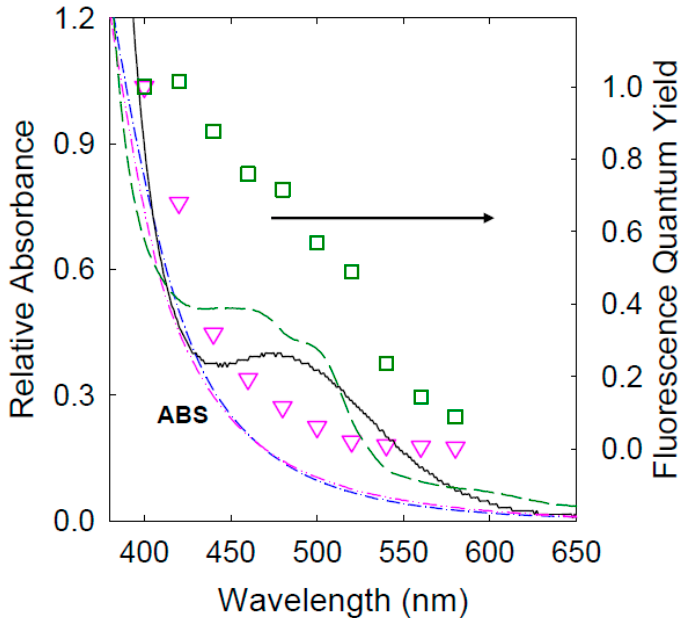
Figure 5. Absorptions (ABS) and fluorescence quantum yields at different excitation wavelengths of the two samples from processing the citric acid–formamide (CA–FA) mixture at 160 °C for 1 h (dash line and □ ) and at 300 °C for 2 h (dash-dot-dot-dash line and ▽ ) are compared, where the yields are normalized against the values at 400 nm excitation of 20% for the former and 14% for the latter. The normalized absorption spectra of the as-supplied MilliporeSigma sample solution (solid line and EDA-CDots (dash-dot-dash line) are also shown for comparison.